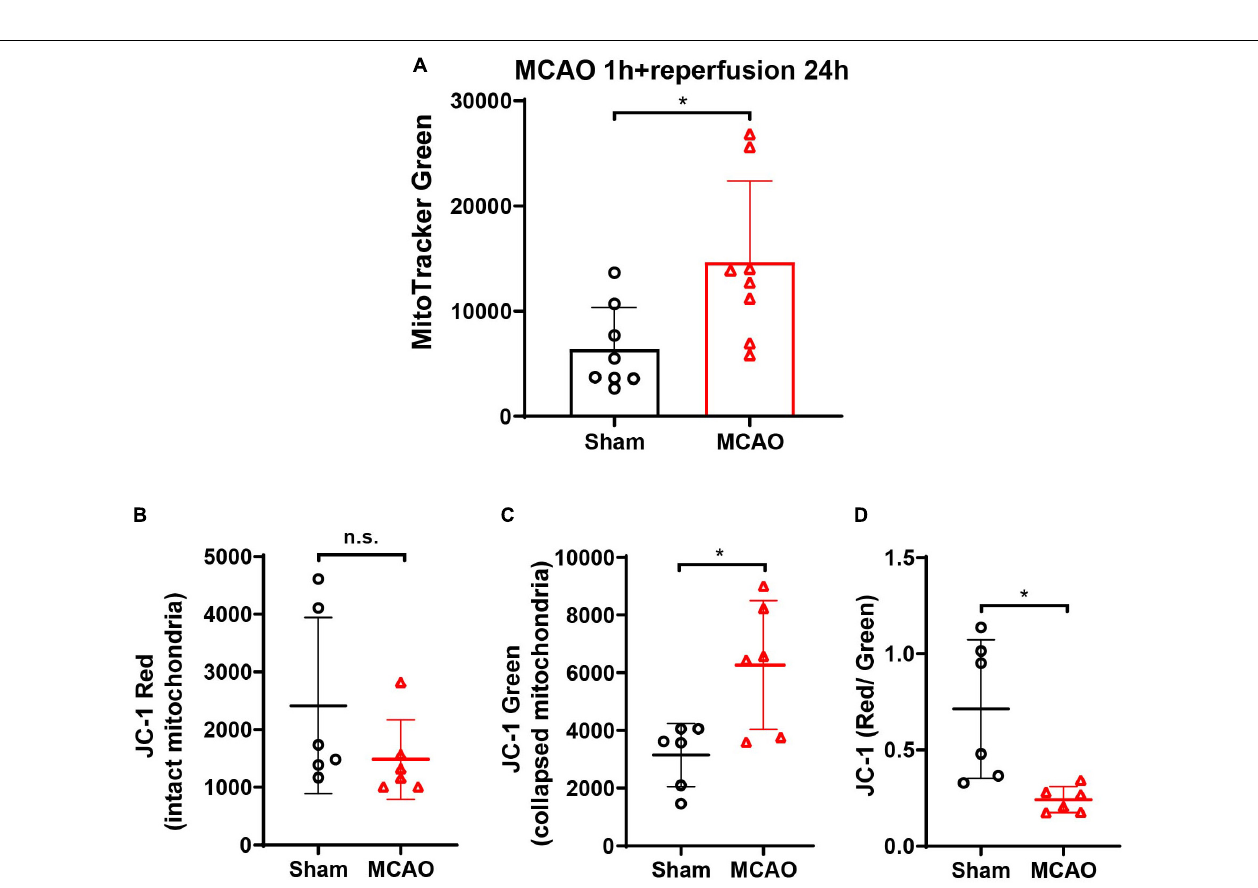
FIGURE 7 | The detection of mitochondria and (cid:49) ψ m (JC-1 red/green ratio) in the CSF of MCAO mice. (A) After cerebral ischemia, the MitoTracker Green-labeled mitochondria elevated significantly in CSF at 24-h post-reperfusion. n = 8. * p < 0.05 vs. Sham. (B) The JC-1 staining in CSF showed no significant difference of JC-1 red between the Sham and MCAO groups. (C) JC-1 green increased significantly in the CSF after MCAO when compared with the Sham group. (D) JC-1 red/green ratio decreased significantly in the CSF after MCAO. n = 6. * p < 0.05 vs. Sham. CSF, cerebrospinal fluid; MCAO, middle cerebral artery occlusion; n.s., not